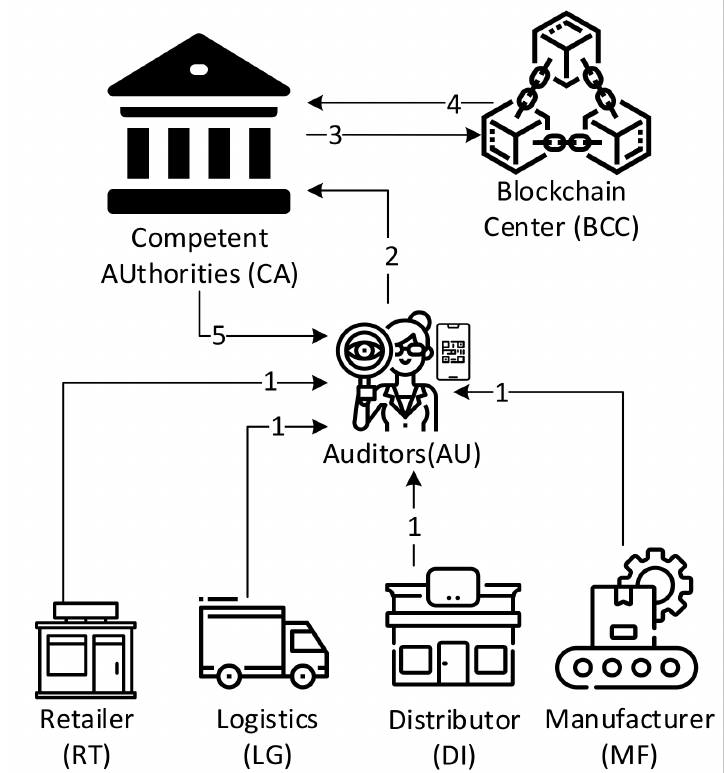
Figure 13. The audit mechanism in the verification